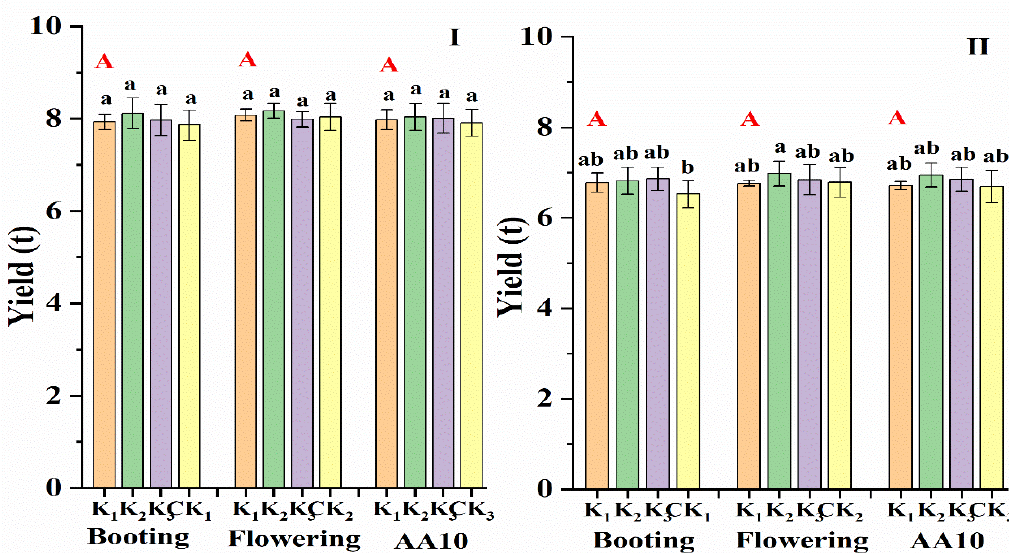
Figure 2. Effects of potassium foliar application on the grain yield of wheat. I represented Xinong 20, and Ⅱ represented Xiaoyan 22. Booting (BBCH 48), Anthesis (BBCH 65), and AA10 (BBCH 71): Potassium fertilizer foliar sprayed at booting stage, anthesis stages, and 10 days post anthesis, respectively. K 1 , K 2 , and K 3 represented the application concentration of potassium 30, 60, and 90 mmol L − 1 , respectively. CK: Same amount of deionized water was sprayed on the leaves. Vertical bars represent the mean values ± standard deviation (n = 3). Different lower-case letters indicate a significant difference ( p < 0.05). Different capital letters indicate a significant difference ( p < 0.05) among different spraying stages.